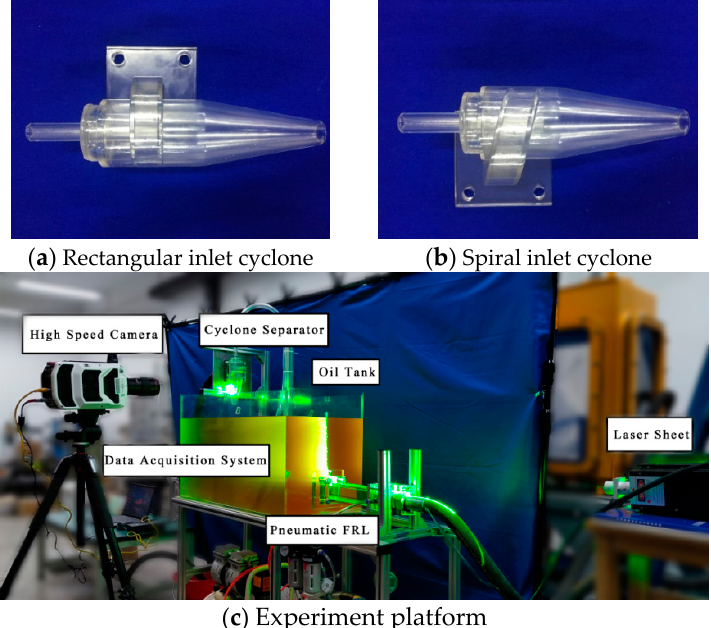
Figure 13. Experimental platform for visualization of bubble flow in cyclone.